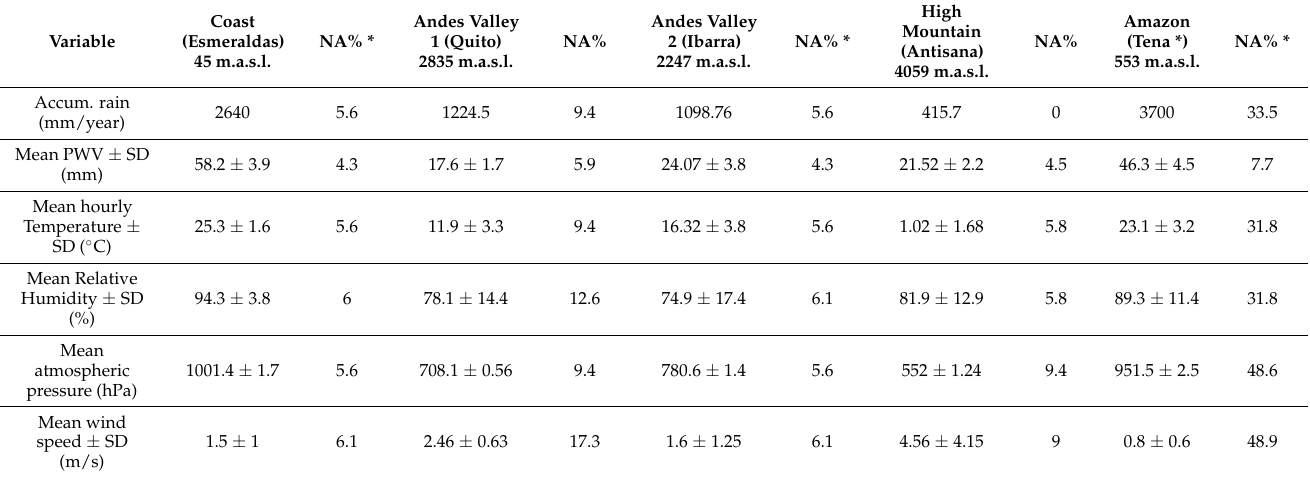
Table 3. Accumulated rain, annual average, and standard deviation of the studied hourly meteoro- logical variables for the year 2014. NA% is the percent of data loss per variable and * means that the data for these stations were only available from 21 July to 31 December